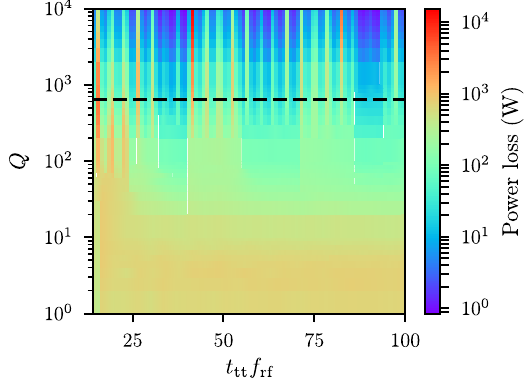
FIG. 16. Power losses from the HOM in the single-cell cavity (mode 1 in Table III) for different train spacings t quality factors Q . Calculations are done for parameters of the Z machine with 2.5 ns bunch spacing. The dashed black line indicates the quality factor required for the longitudinal beam stability.